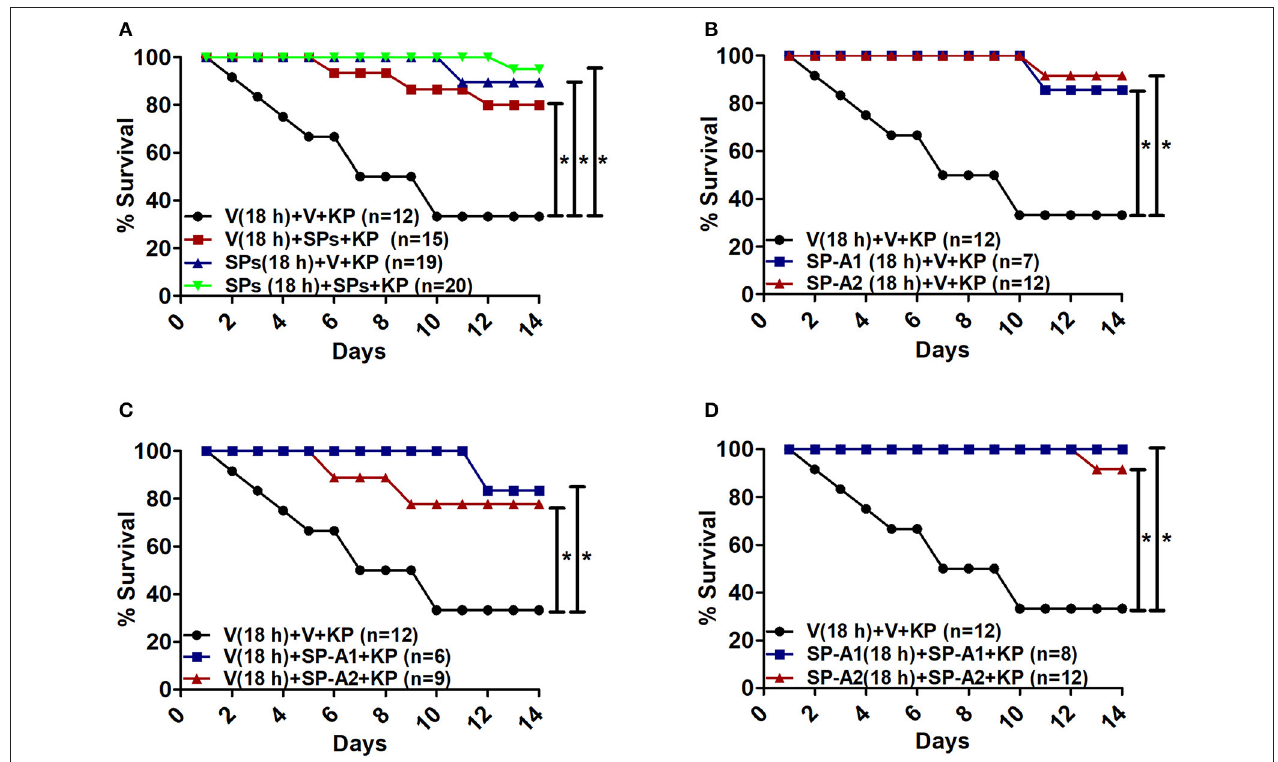
FIGURE 7 | Rescue by exogenous SP-A1 or SP-A2 treatment . (A) Depicts overall survival of infected KO mice after surfactant protein (SPs) treatment. (B) Depicts KO mouse survival after pretreatment with SP-A1 or SP-A2 prior to infection, (C) depicts KO survival after pretreatment with vehicle (Vp) and rescue at the time of infection with SP-A1 or SP-A2, (D) depicts KO survival after pretreatment with SP-A1 or SP-A2 and rescue with SP-A1 or SP-A2 at the time of infection. Mouse survival was monitored for 14 days after infection and treatment. Significant differences are indicated for survival * p <